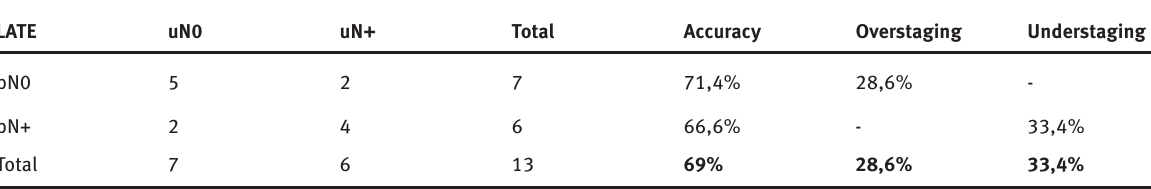
Table 5: Sensivity, specificity, PPV, NPV for N staging